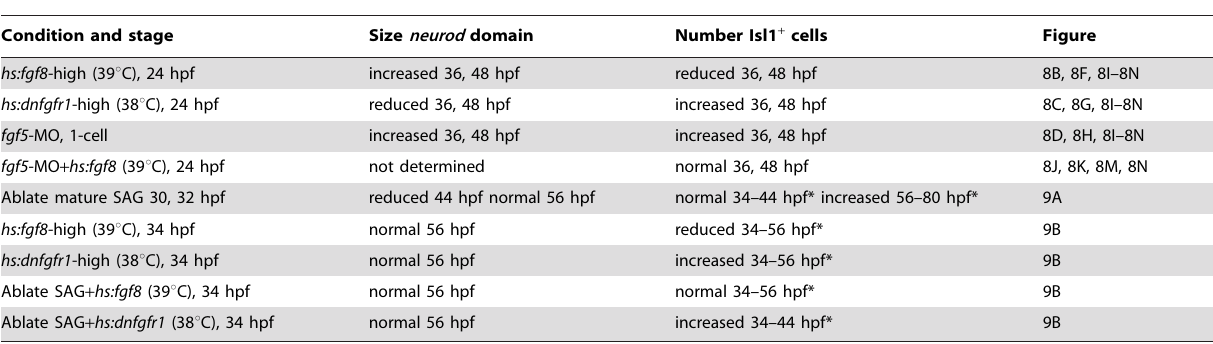
Table 2. Effects of altering Fgf on SAG maturation.